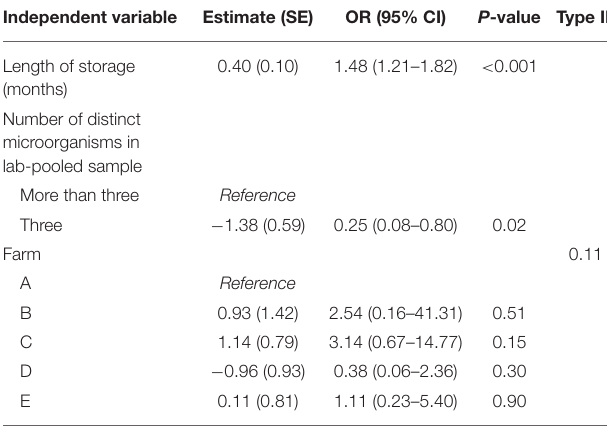
TABLE 6 | Odds of true contamination ∧ in the lab-pooled sample based on mixed logistic regression modelling. Independent